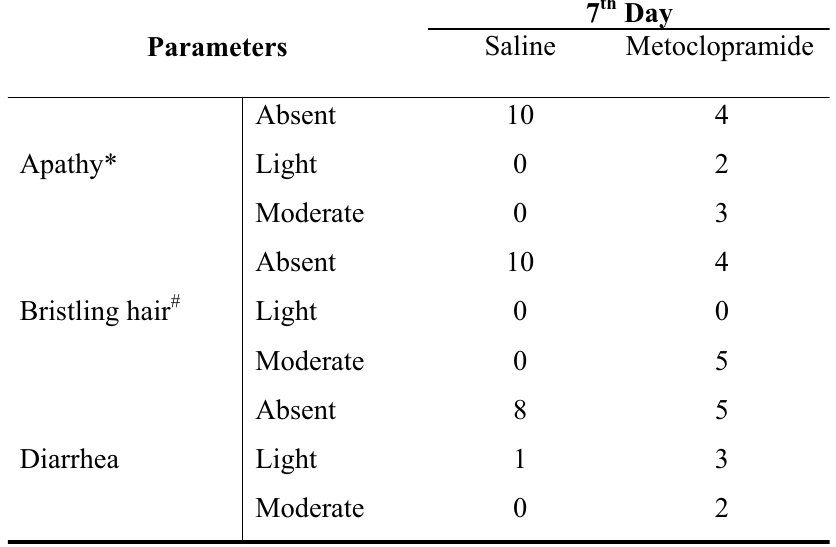
TABLE 2 - Number of animals and the clinical evaluation parameters for each group in the seventh postoperative